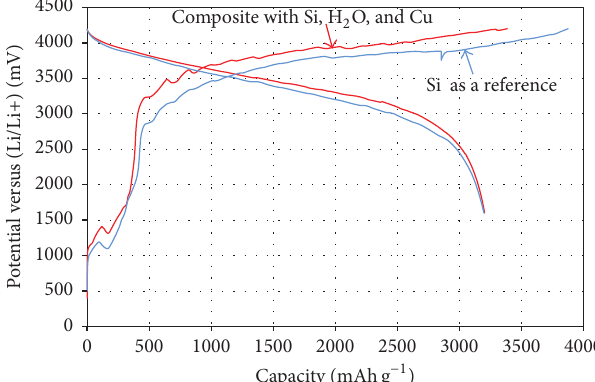
Figure9:Charge-dischargecapacityprofilesofthecompositeanode (red) and a Si particle reference